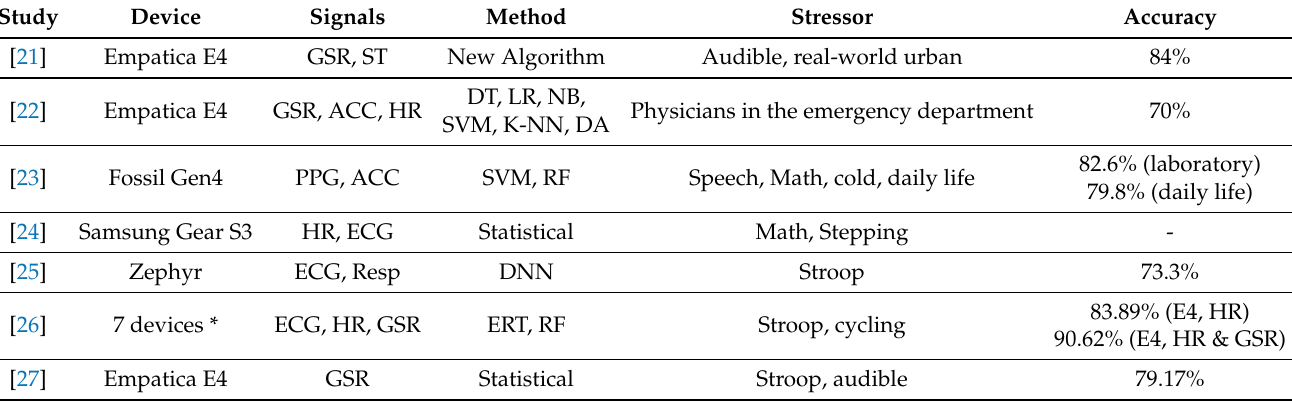
Table 1. A list of the cited works with the protocol tasks used and the performances of the machine- learning algorithms. Abbreviation: HR: Heart Rate; ECG: Electrocardiogram; Resp: Respiration; ST: Skin Temperature; GSR: Galvanic Skin Response; ACC: Acceleration; PPG: Photoplethysmogram; DNN: Deep Neural Network; RF: Random Forest; DA: Discrimination Analysis; ERT: Extremely Randomized Tree; SVM: Support Vector Machine; K-NN: K-Nearest Neighbor; NB: Naïve Bayes; LR: Logistic Regression; DT: Decision Tree. * 7 devices are BITalino (r)evolution board,